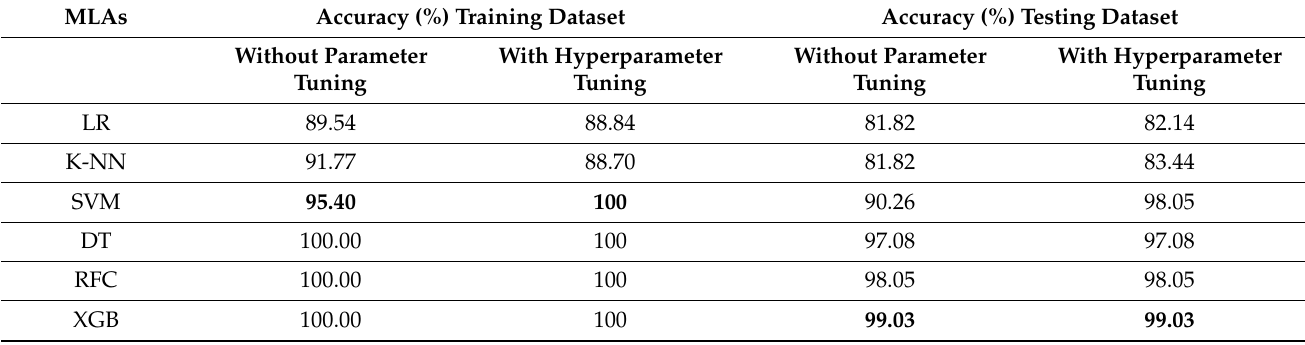
Table A5. Comparison of the accuracy when using the training and testing datasets with and without tuned